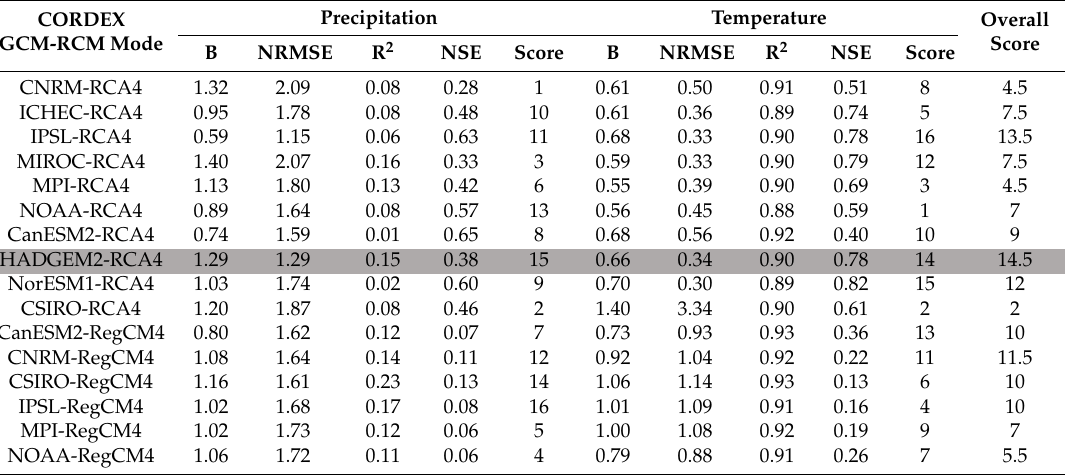
Table 3. Statistical performances of the available CORDEX GCM-RCM models of WAS-44, and the resulting skill score for precipitation and temperature, with the best model highlighted in